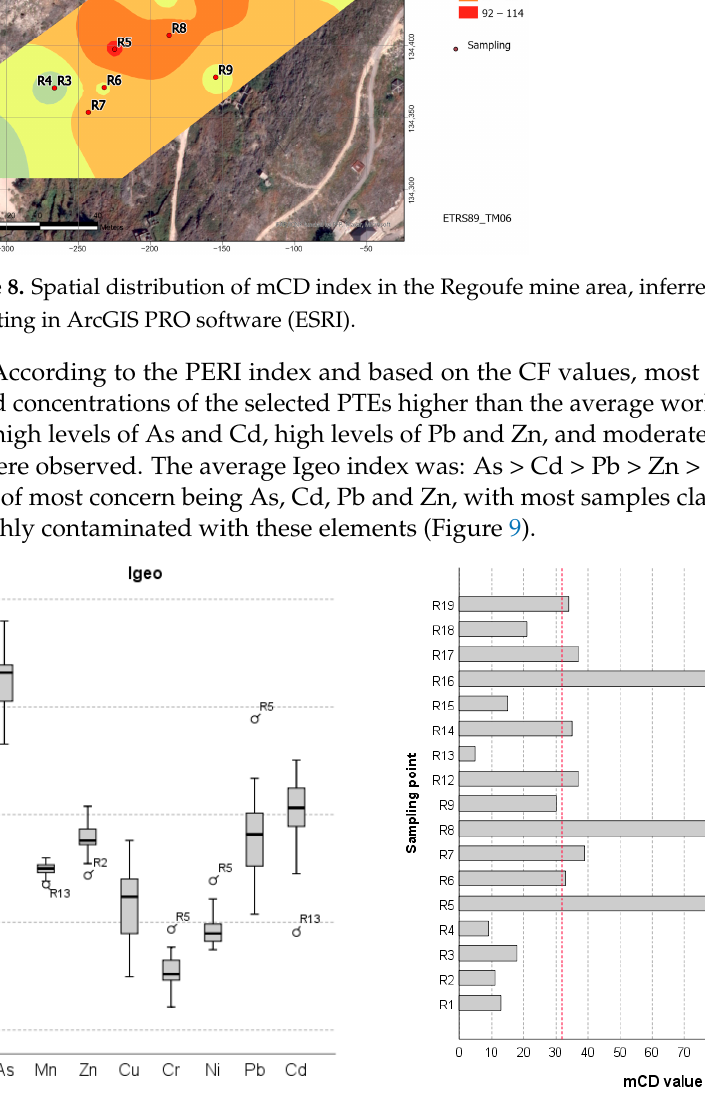
Figure 9. Geoaccumulation index (Igeo) and modi fi ed degree of contamination (mCD) for the different soil surface samples collected at Regoufe mine, main valley. Extreme value labels at Igeo correspond to the location of the sampling point as in Figure 8; red do tt ed line indicates the mCD value above which is considered an ultra-high degree of contamination.